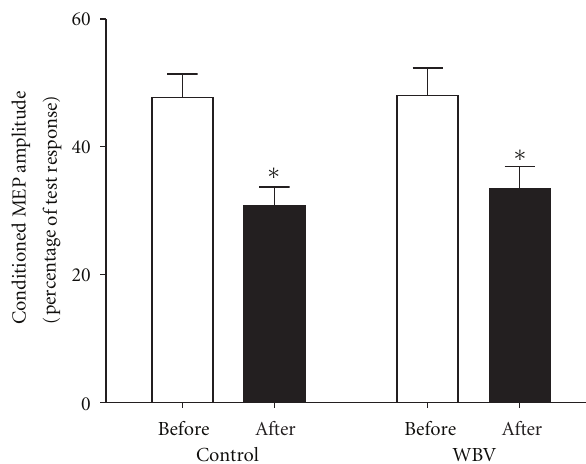
Figure 4: Mean ( ± SE) absolute change in SICI expressed as the ratio between conditioned MEPs and test MEPs for both groups before and after the 4wk intervention. The training protocol resulted in significant reductions in SICI for both training groups ( P < 0 . 05). However, the magnitude of change between training groups was not significantly di ff erent ( P = 0 .